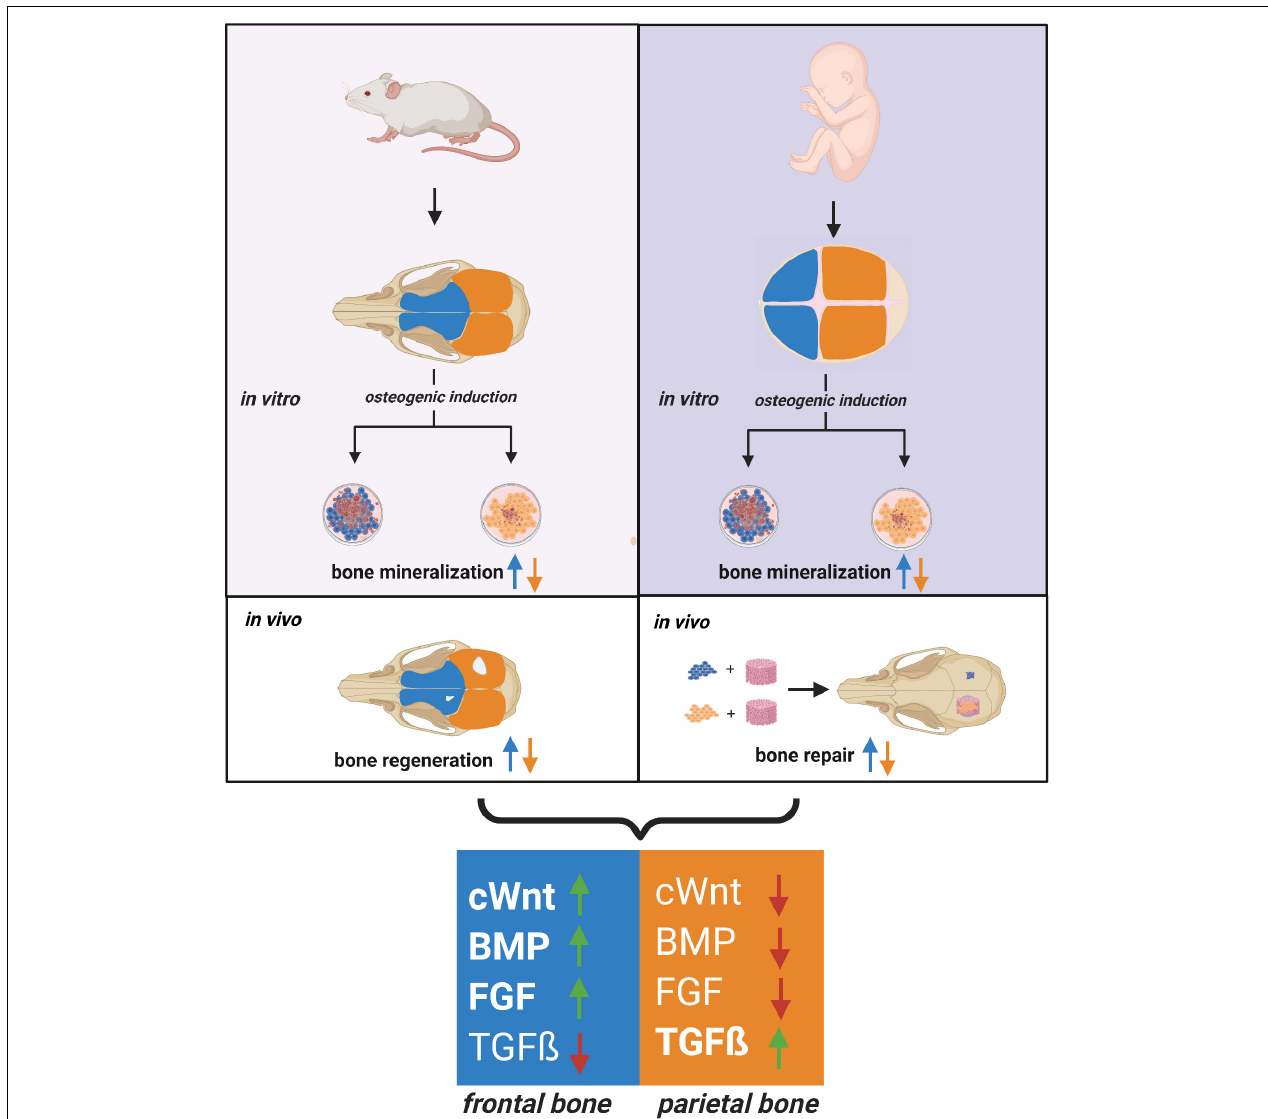
FIGURE 4 | Relationship between human and mouse calvarial bones of neural crest and mesodermal origin. Cartoon depicting a close relationship between the human and mouse osteoskeletal capacity of frontal and parietal bones and –derived osteoblast. Similarities between the pro-osteogenic signaling pathways differentially activated in frontal and parietal bones-derived osteoblasts are schematically illustrated. Code colors: blue defines frontal bone and derived osteoblast; orange defines parietal bone and derived